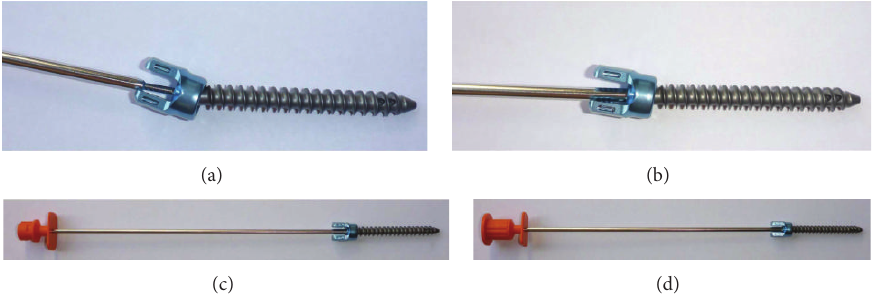
Figure 3: Exemplary assembly of injection cannula and polyaxial cannulated and fenestrated screw for percutaneous cement augmentation. The injection cannula is initially inserted unfilled into the polyaxial screw head (a) to check the proper fit and entry trajectory (b). After removing and filling the injection cannula with bone cement outside of the patient’s body, the filled injection cannula is reinserted (c). Gradually inserting the pusher into the injection cannula (under fluoroscopic monitoring) bone cement is injected into the screw and surrounding vertebral body through the distal fenestrations (d) (bone cement not